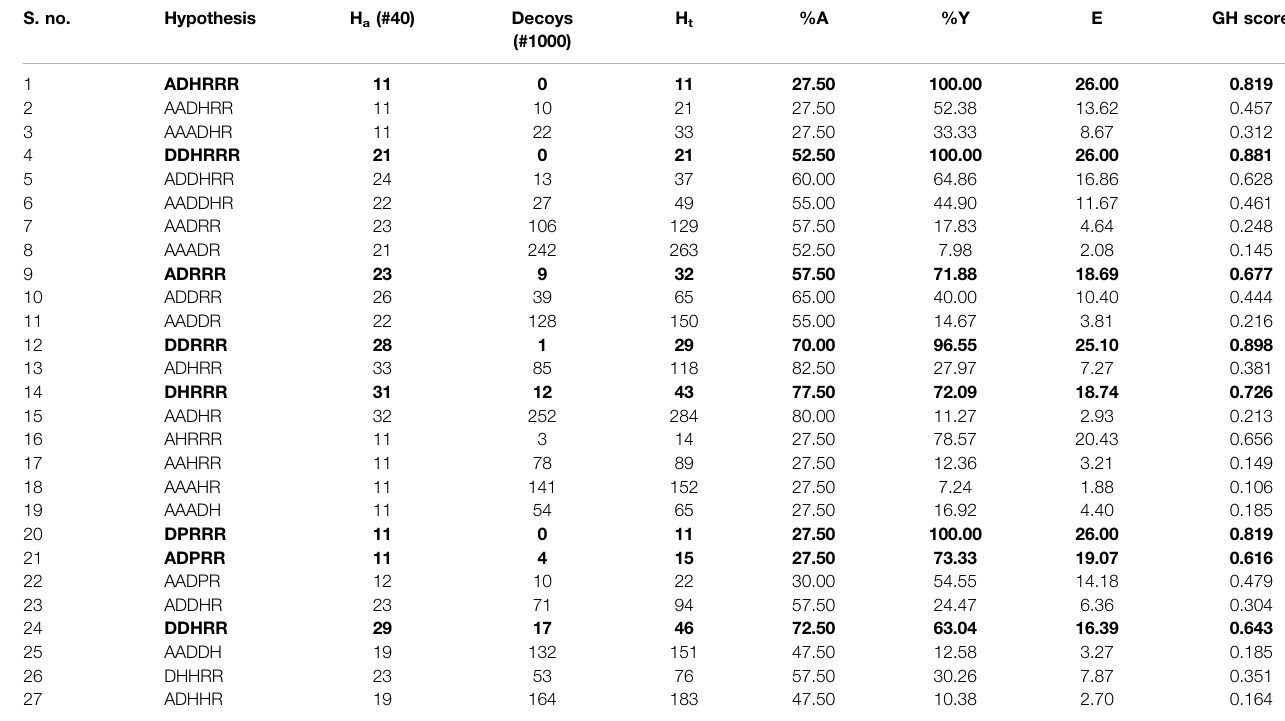
TABLE 3 | Pharmacophore validation results from potency validation. S.